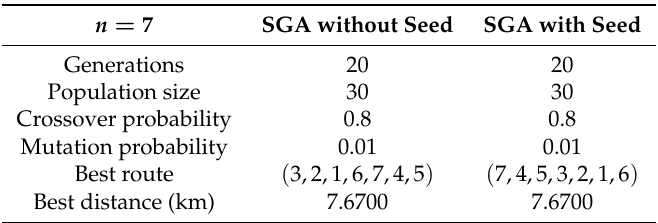
Table 6. Results of the n = 7 problem.